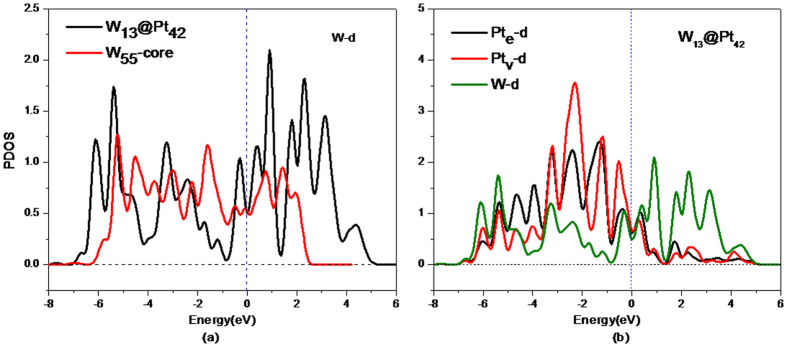
The d-state PDOS of the W and Pt atoms.(a) W atoms in W13@Pt42 and W55; (b) W and Pt atoms in W13@Pt42.